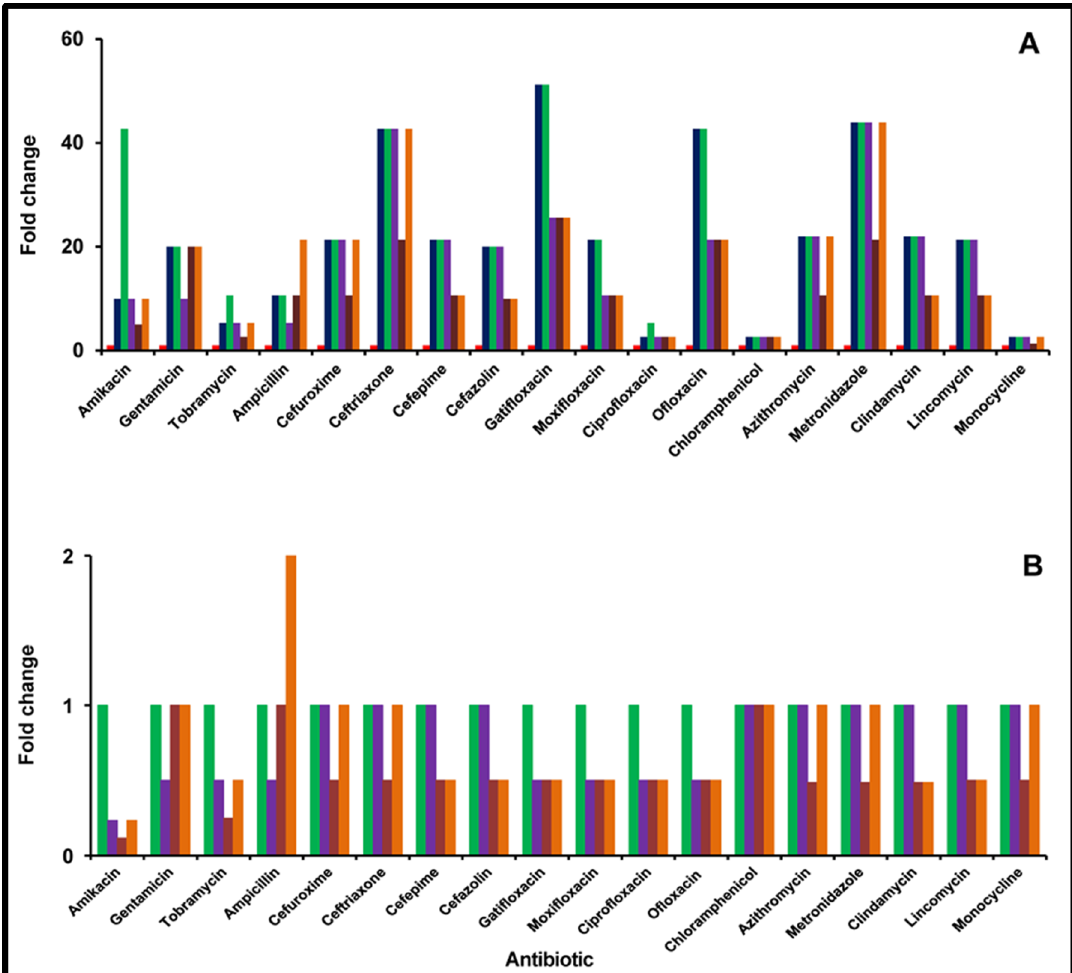
Figure 6. Fold change in minimum biofilm eradication concentration of the antibiotic (MBEC) of monomicrobial ( S. aureus ) and polymicrobial ( S. aureus plus C. albicans ) biofilms compared to planktonic cells of S. aureus ( A ) and comparison of MBEC between monomicrobial ( S. aureus ) and polymicrobial ( S. aureus plus C. albicans ) biofilms ( B ). The effect of the antimicrobial agent was evaluated by the XTT method as described. The coloured bars indicate the following: red square , S. aureus in the planktonic phase (24 h); blue square, S. aureus in the biofilm phase (24 h); green square, S. aureus in the biofilm phase (48 h); purple square, S. aureus and C. albicans simultaneously incubated to form biofilm (24 h); brown square, C. albicans biofilm preformed for 24 h and then S. aureus planktonic cells were added; orange square, S. aureus biofilm